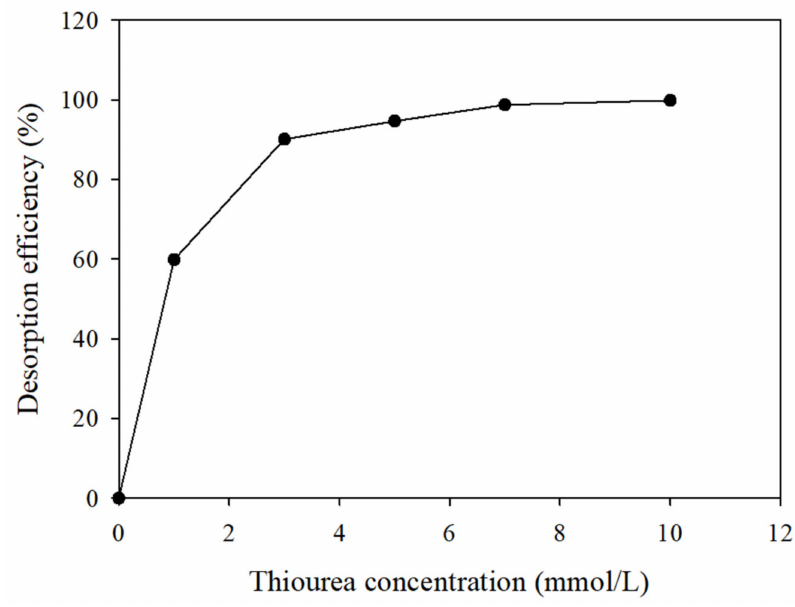
Figure 5. Pd(II) desorption using different concentrations of thiourea in 0.01 M HCl